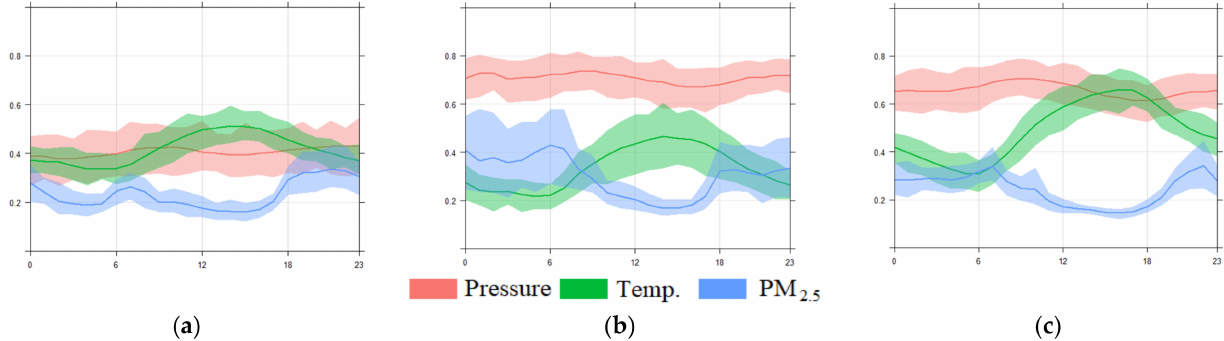
Figure 4. Normalized pressure, temperature and PM 2.5 concentrations in different hours of the day (min-max normalization for the whole period) ( a ) before emergency state 1–15 March ( b ) during emergency state 16–31 March, Aralkum episode excluded ( c ) during emergency state 1–15